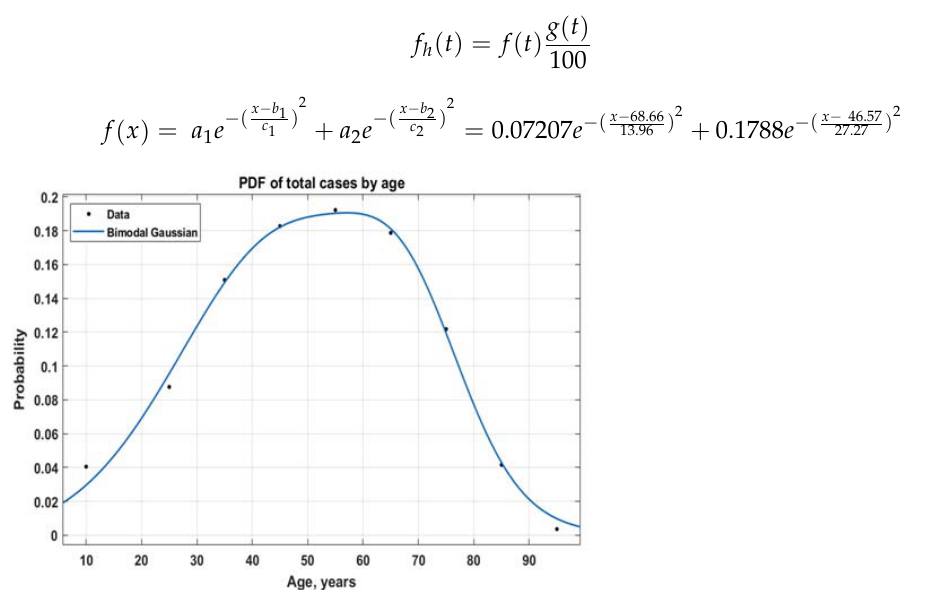
Figure 1. Probability density function of new cases by age for total cases up to 3 September 2021.